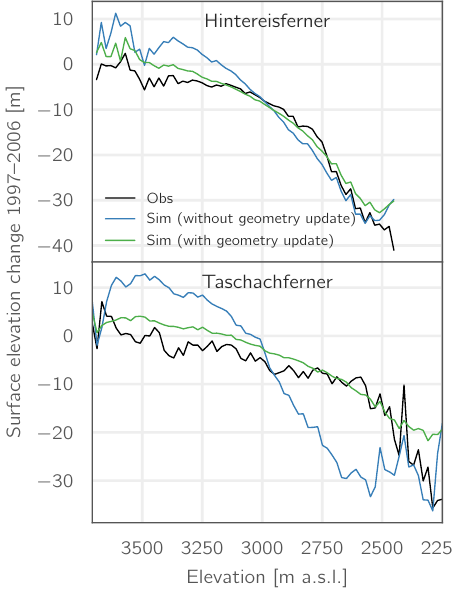
Figure 3. Observed and simulated glacier surface elevation change during the period 1997–2006 as a function of elevation for the glaciers Hintereisferner and Taschachferner (see Fig. 1 for their ge- ographical setting). “Without geometry update” refers to the simu- lated surface mass balances without accounting for ice flow, while “with geometry update” refers to the simulation results obtained af- ter implementing the (cid:49)h